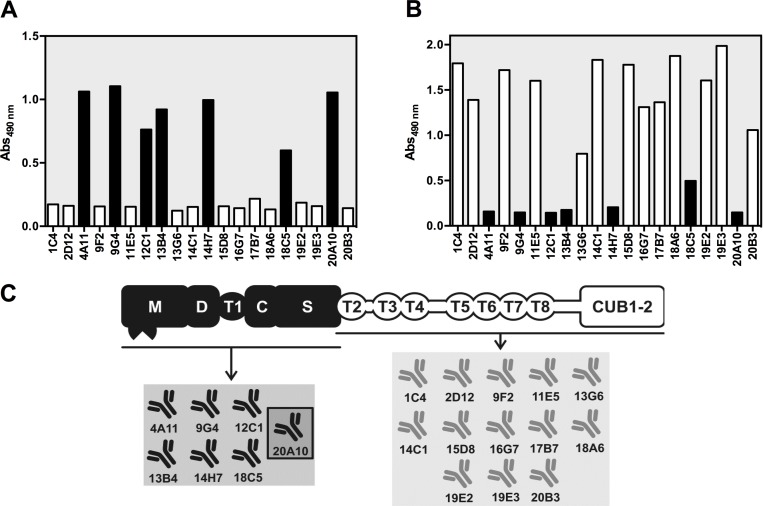
Epitope mapping and epitope overview of the developed anti-mADAMTS13 mAbs.The epitope of each anti-mADAMTS13 mAb was mapped against both mMDTCS (A) and mT2-CUB2 (B). Individual anti-mADAMTS13 mAbs were coated, recombinant mMDTCS (A) or mT2-CUB2 (B) were added and binding of the respective mADAMTS13 variant was detected using the polyclonal anti-mADAMTS13 rabbit IgG and GAR-HRP. Black and white bars represent respectively anti-mMDTCS and anti-mT2-CUB2 mAbs. The previously reported mAb 20A10 [31] was used as a positive (A) and negative (B) control. (C) Epitope overview of the developed anti-mADAMTS13 mAbs. The previously developed mAb 20A10 [31] is marked by a dark frame.